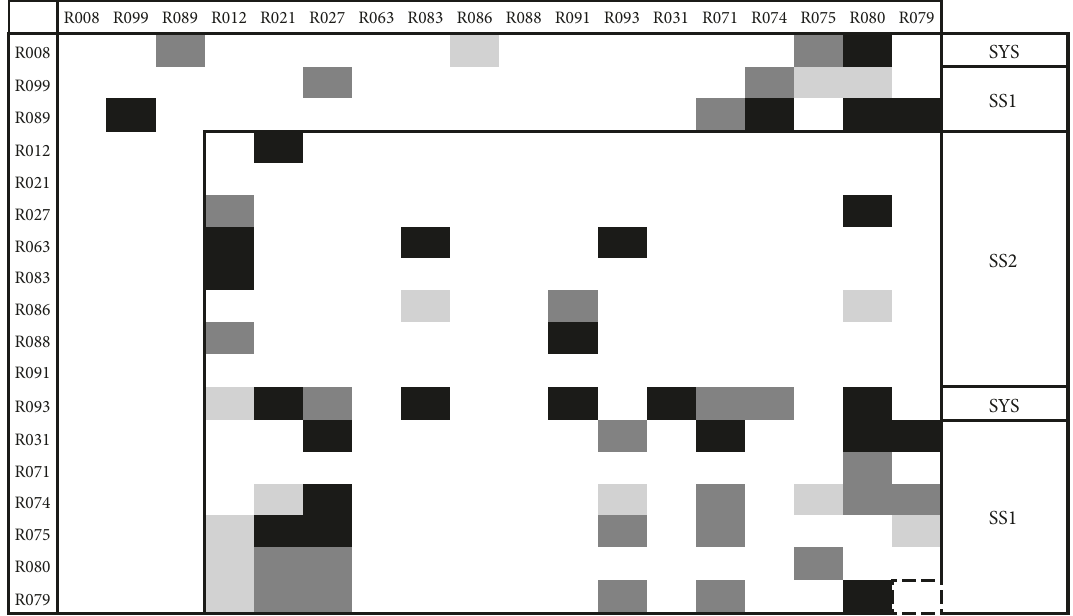
Figure 5: Display of cluster C 1 and the 3 transverse risks.